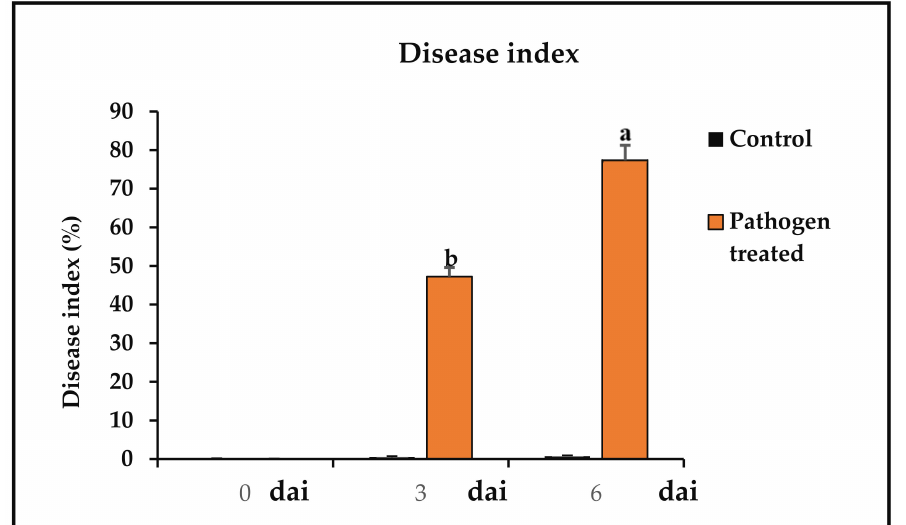
Figure 3. The disease index of C. truncatum -inoculated chilli fruit. Each value is expressed as mean of triplicates, and the bars sharing the same alphabetical letters are not significantly different ( p ≤ 0.05) using Duncan’s multiple range test. The vertical bar designates the standard